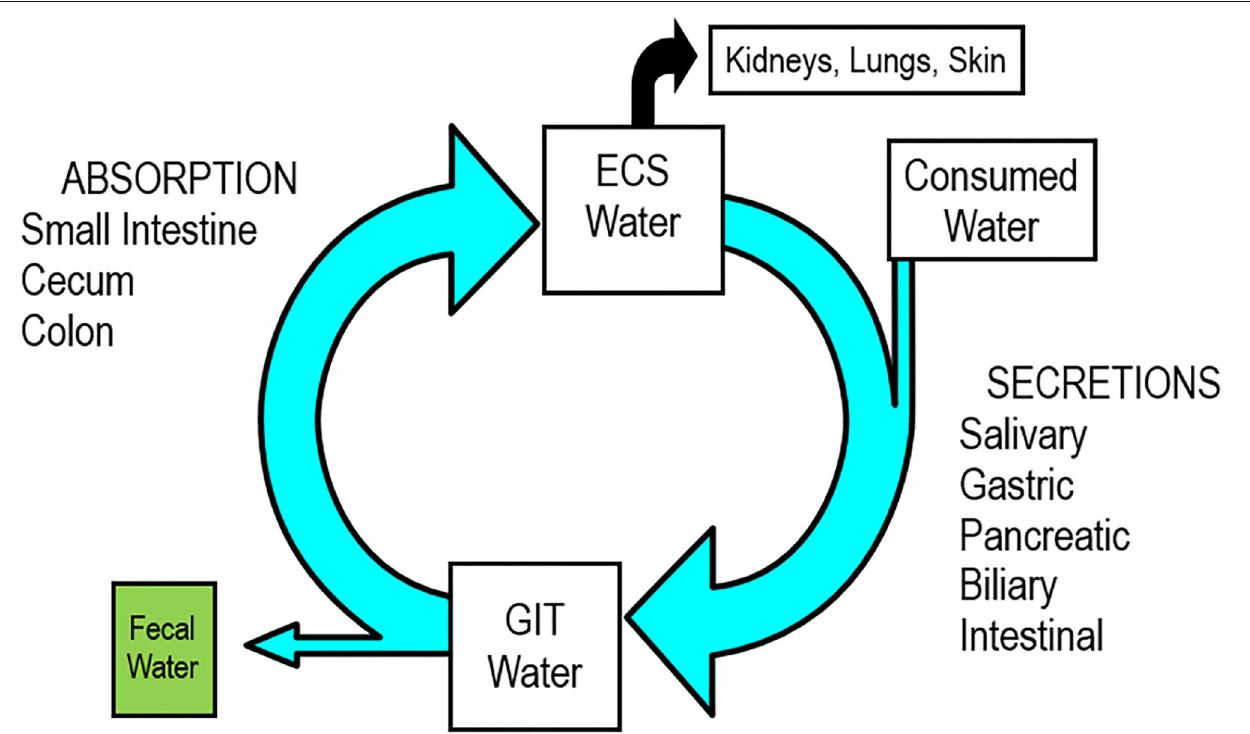
FIGURE 1 | Enterosystemic cycle in the healthy horse, to demonstrate the interplay between the gastrointestinal tract and the extracellular fluid (ECF) space. Absolute values are not included, which would identify the relative contributions of each process or segment to the overall scheme, although different sizes of arrows and boxes represent approximate relationships. Font sizes do not represent differences, such that the cecum and colon are responsible for greater water and electrolyte absorption than the small